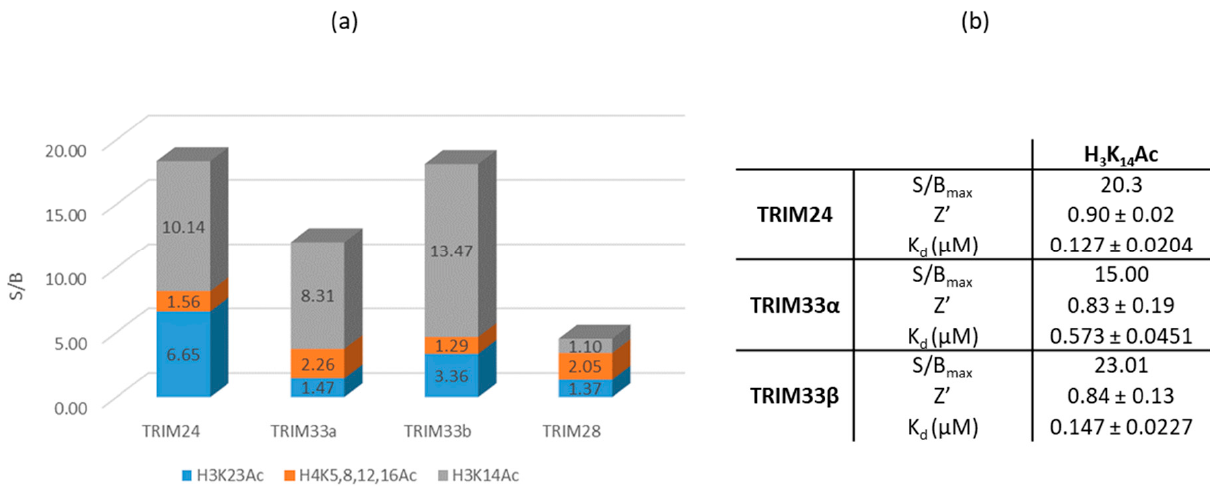
Figure 11. ( a ) Preliminary HTRF assay to evaluate the affinity of 3 different peptides against TRIM24, TRIM33 α , TRIM33 β , and TRIM28 (as negative control). The value reported refers to the S/B ratio detected using histone peptide at a concentration of 3 µ M. ( b ) S/B ratio, Z’ and K d values were calculated performing titration curves of H 3 K 14 Ac with TRIM24, TRIM33 α , and TRIM33 β . Values quoted are the mean of triplicate data ± standard error of the mean.